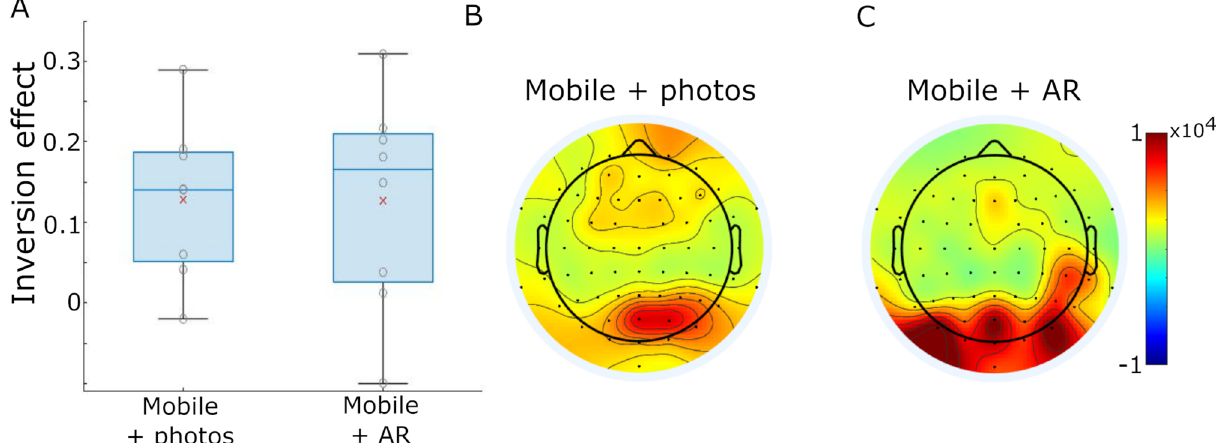
Figure 5. GLM-based results. ( A ) Face inversion effect sizes for the mobile experimental tasks based on the posterior electrodes. Red x indicates group mean inversion effect with individual subjects shown by grey circles. ( B ) Topography showing mean power difference for inverted-upright faces between 5 and 15 Hz for the mEEG + photos task, and ( C ) the mEEG + AR